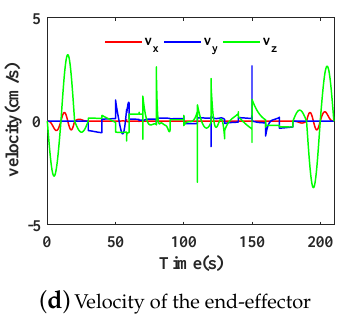
Figure 9. Experimental results of writing on a white board.